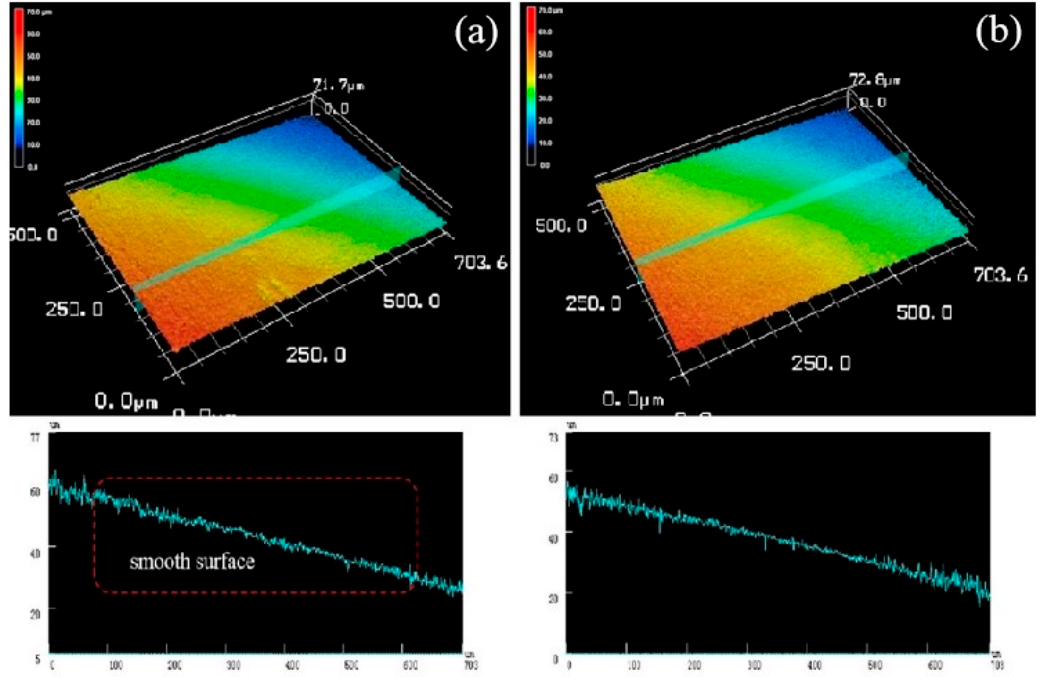
Figure 15. Both ( a ) and ( b ) were three-dimensional corrosion morphology of extruded alloy (300 °C) after corrosion product removal.